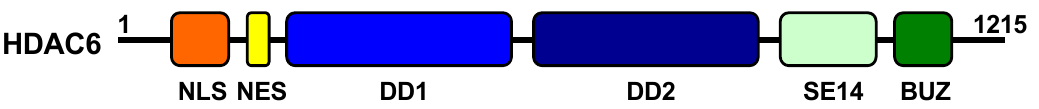
Figure 4. Protein structure of histone deacetylase 6 (HDAC6). The HDAC6 protein consists of 1215 amino acids. It has a nuclear localization sequence (NLS), a nuclear export sequence (NES), two functional active catalytic (SC) sites, a cytoplasmic retention signal of eight consecutive serine-glutamic acid tetradecapeptides (SE14), and a ubiquitin-binding domain (BUZ) at the C-terminal.